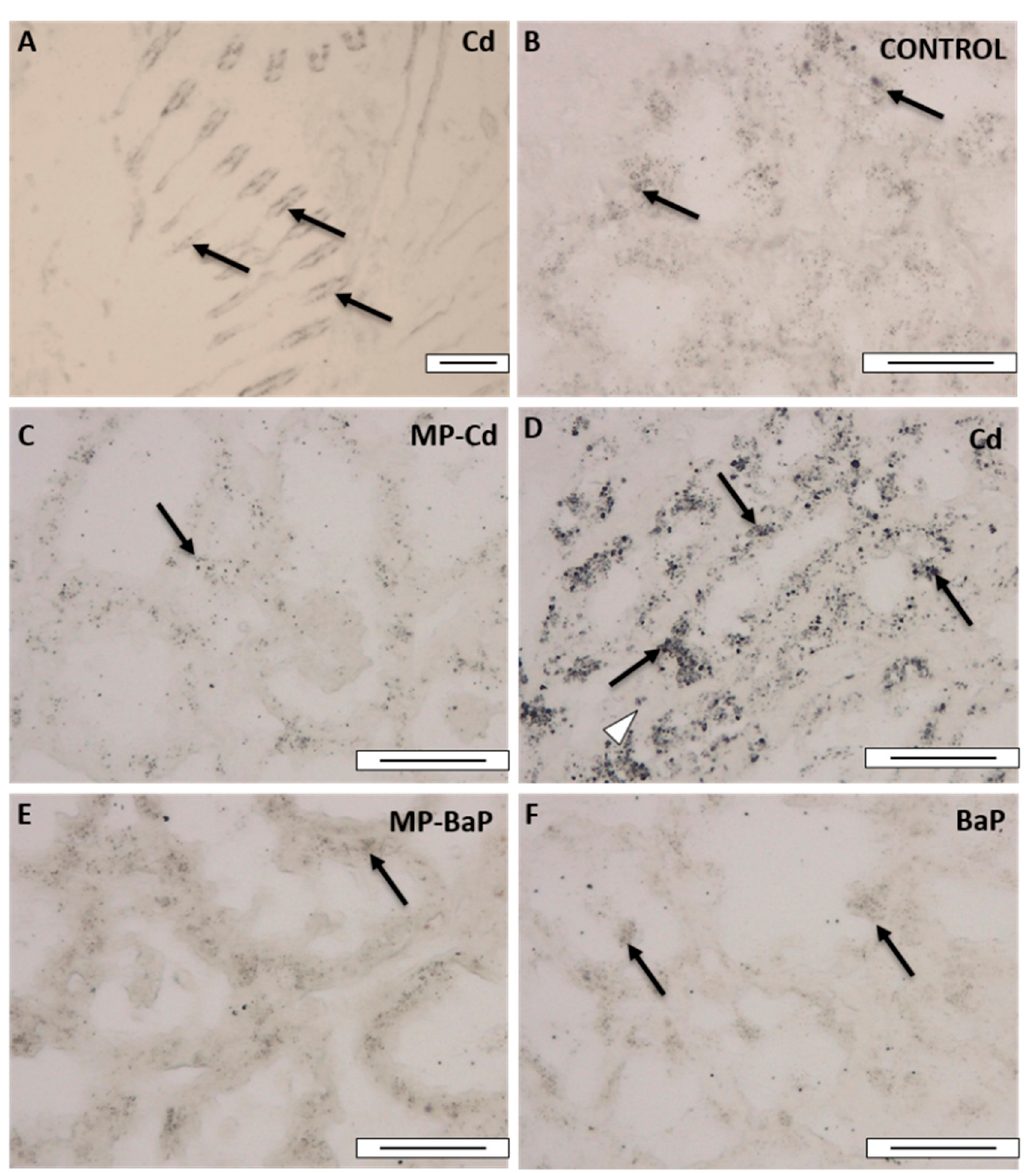
Figure 5. Micrographs of the gills ( A ) and digestive gland ( B – F ) of mussels after autometallographical staining. ( A ) Mussel exposed to 1 µ M Cd for 3 days; ( B ) control mussel; ( C ) mussel exposed to 1000 particles/mL 4.5 µ m MP-Cd for 3 days; ( D ) mussel exposed to 1 µ M Cd for 3 days; ( E ) mussel exposed to 1000 particles/mL 4.5 µ m MP-BaP for 3 days; ( F ) mussel exposed to 1 µ M BaP for 3 days. Black silver deposits indicate the presence of metals in the gill cells (black arrows in A ), in the digestive tissue (black arrows in B – F ) and haemocytes (white triangle in D ). Scale bars: 50 µ